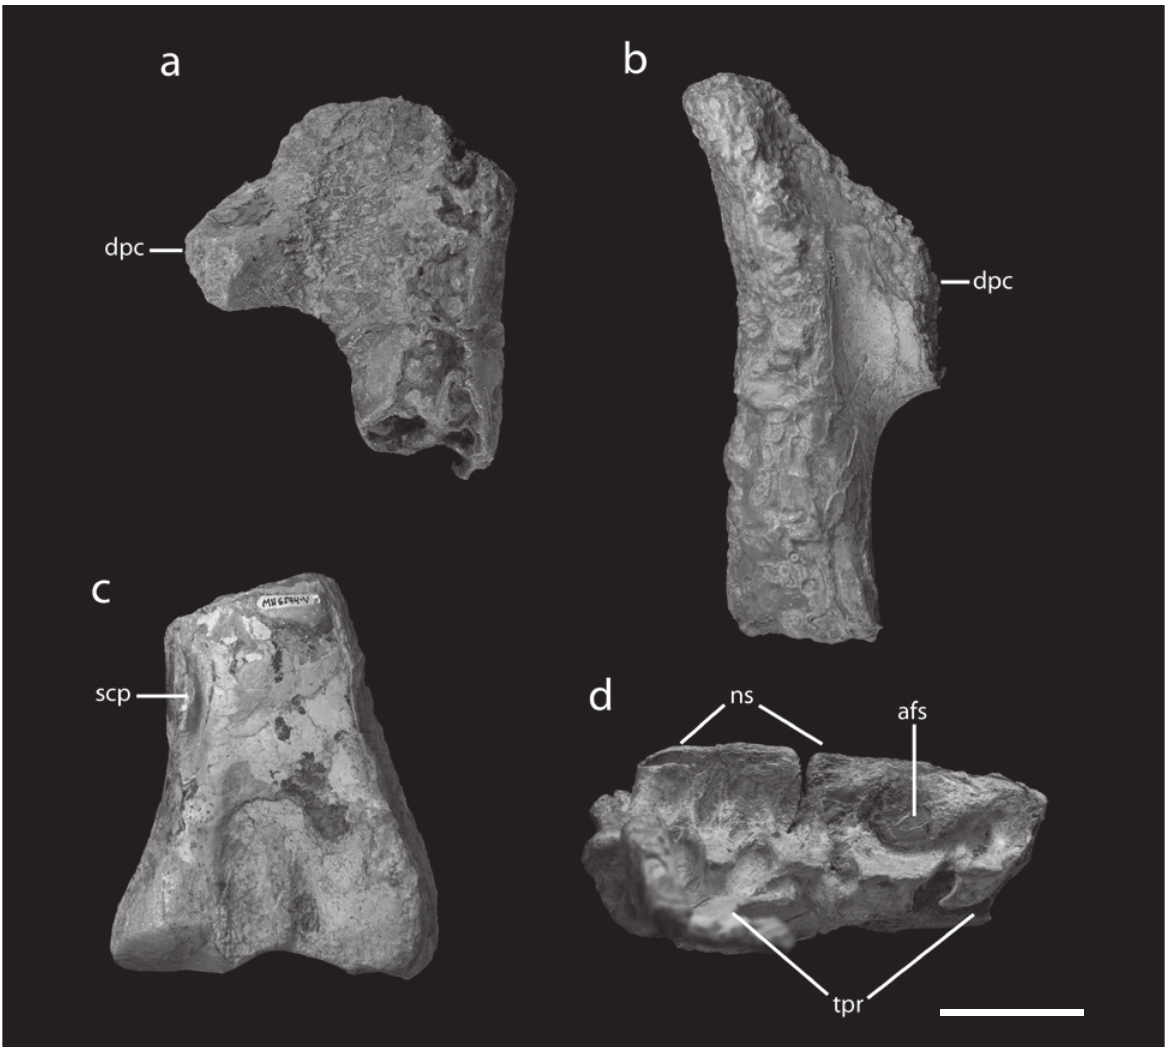
Fig. 7 - Postcranial elements of Tropeognathus cf. T. mesembrinus (MN 6594-V). (a) Proximal portion of the right humerus in medial view. (b) Left humerus in medial view. (c) Distal portion of the right humerus in ventral view. (d) Notarium in left lateral view. See text for abbreviations. Scale bar 50